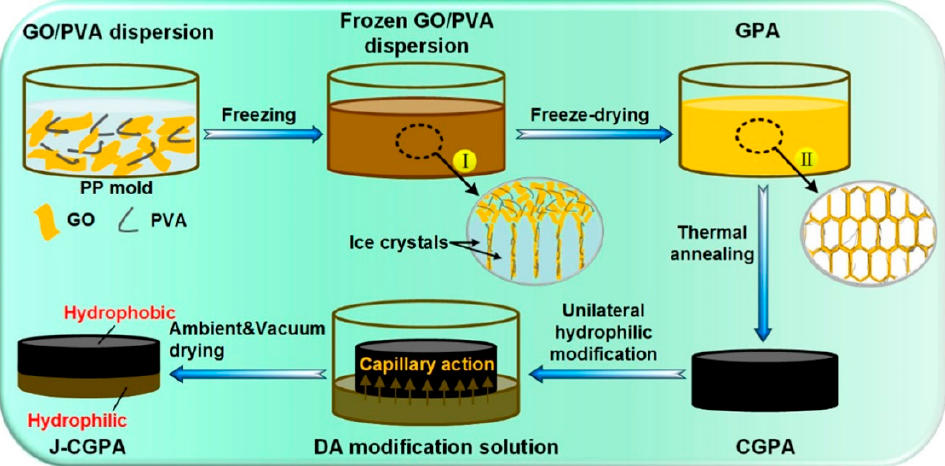
Figure 6. Schematic illustration of the preparation process of J-CGPA aerogel. Reprint with permission from Ref. [66]. Copyright 2019, American Chemical